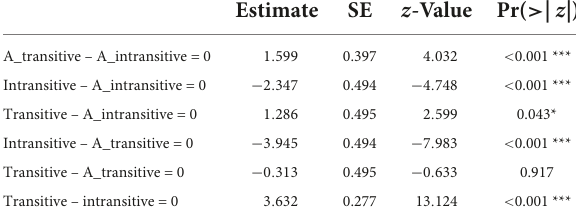
TABLE 3 Generalized linear mixed model for the rating